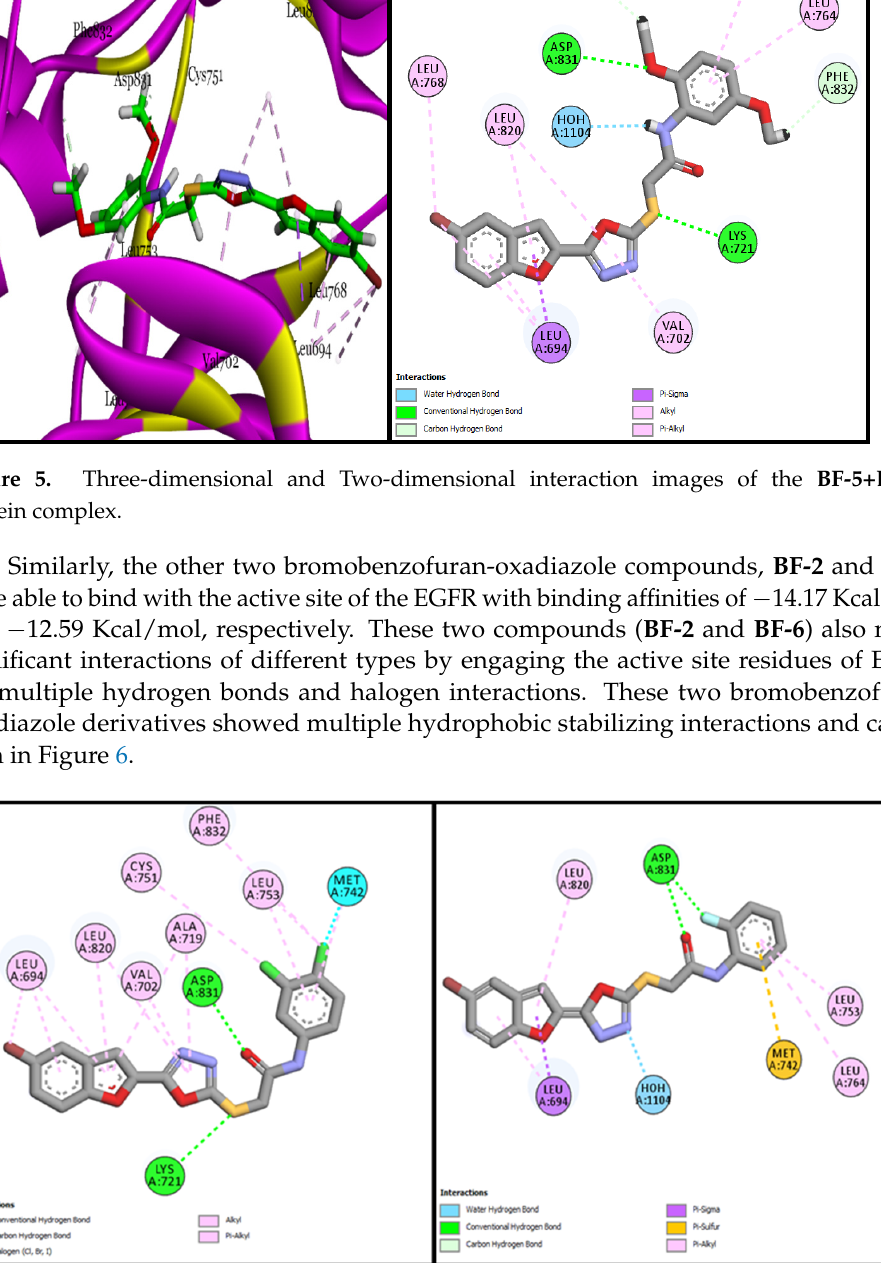
active site are given in Table 3. Table 3. Binding affinities and other docking parameters of BF-2, BF-5, and BF-6 with EGFR.